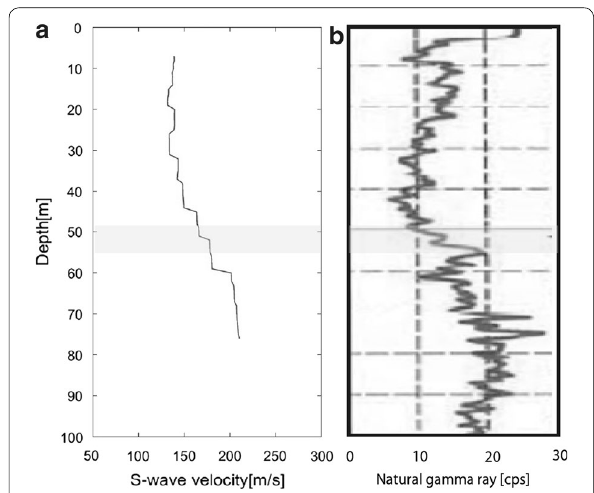
Fig. 5 Comparison of a S-wave velocity profile and b natural gamma ray log data measured at the same location (close to position B in Fig. 1c). The gray-shaded zone indicates the depth of the interpreted sliding